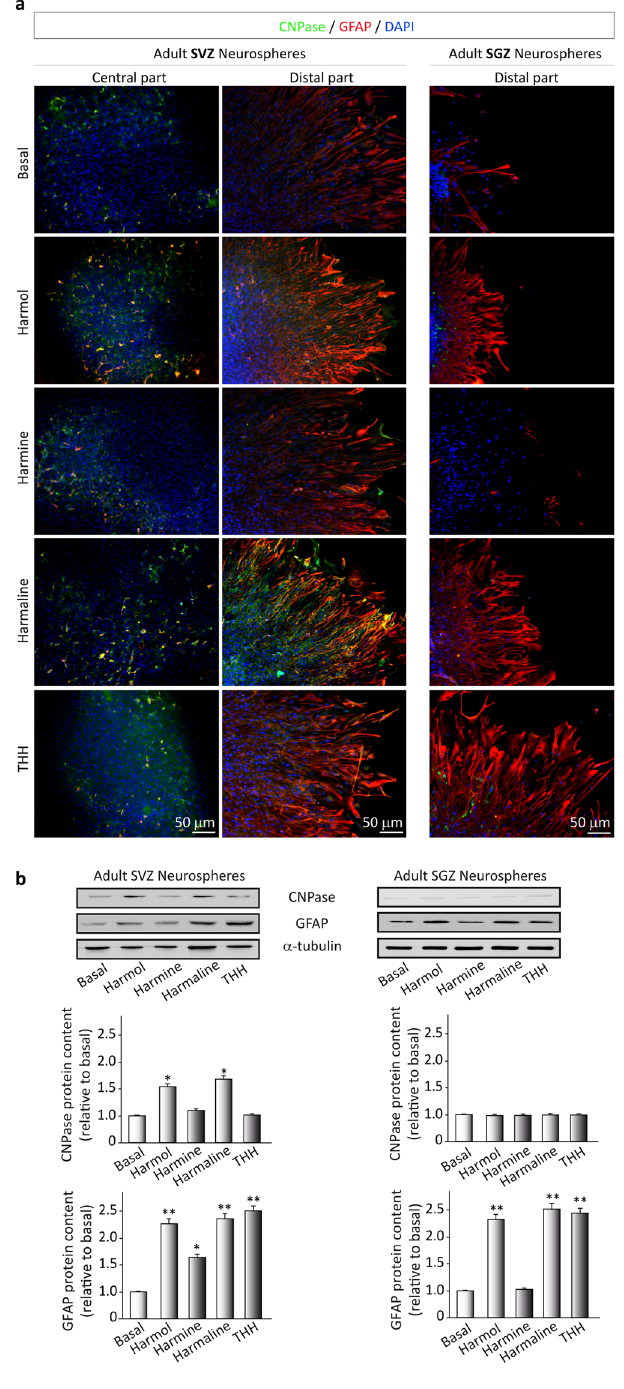
Figure 5. Ayahuasca β -carboline alkaloids promote astrogliogenesis. Neurospheres derived from the adult subgranular (SGZ) and subventricular (SVZ) zone were cultured in the presence of harmol, harmine, harmaline and tetrahydroharmine (THH). After 7 days neurospheres were adhered on coated coverslips and allowed to differentiate for 3 days in the presence of alkaloids at 1 µ M. ( a ) Neurosphere immunofluorescence images showing in green the expression of CNPase (oligodendrocyte marker) and glial fibrillary acidic protein (GFAP, red) that stains astrocytes. SVZ-derived neurospheres are shown in two panels showing the central part of the neurosphere (left) and the distal migration site (right). Single images from SGZ-derived neurospheres show the distal part of the neurosphere. DAPI was used for nuclear staining. Scale bar = 50 μ m. ( b ) Representative Western blots of CNPase and GFAP. Quantification analyses are also shown. Results are the mean ± SD of the quantification of at least three independent experiments corresponding to four different cellular pools. The left side of the image shows results for the subventricular zone (SVZ) of the brain. The right side of the image shows results for he subgranular zone of the hippocampus (SGZ). * p ≤ 0.05; ** p ≤ 0.01 indicate significant results in the post-hoc pair-wise comparisons (Bonferroni) versus non-treated (basal)